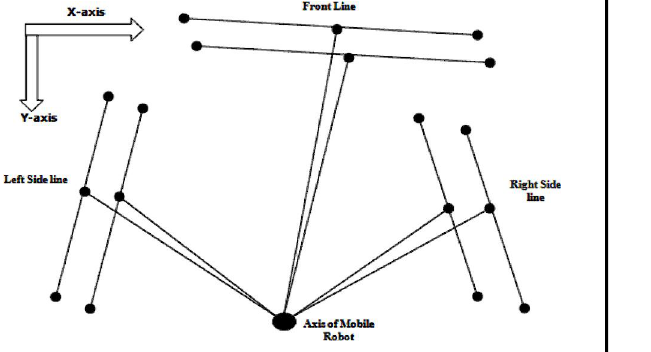
FIG. 10. DIAGRAM TO FIND THE CLOSEST BORDER LINE IN VISION PROCESS